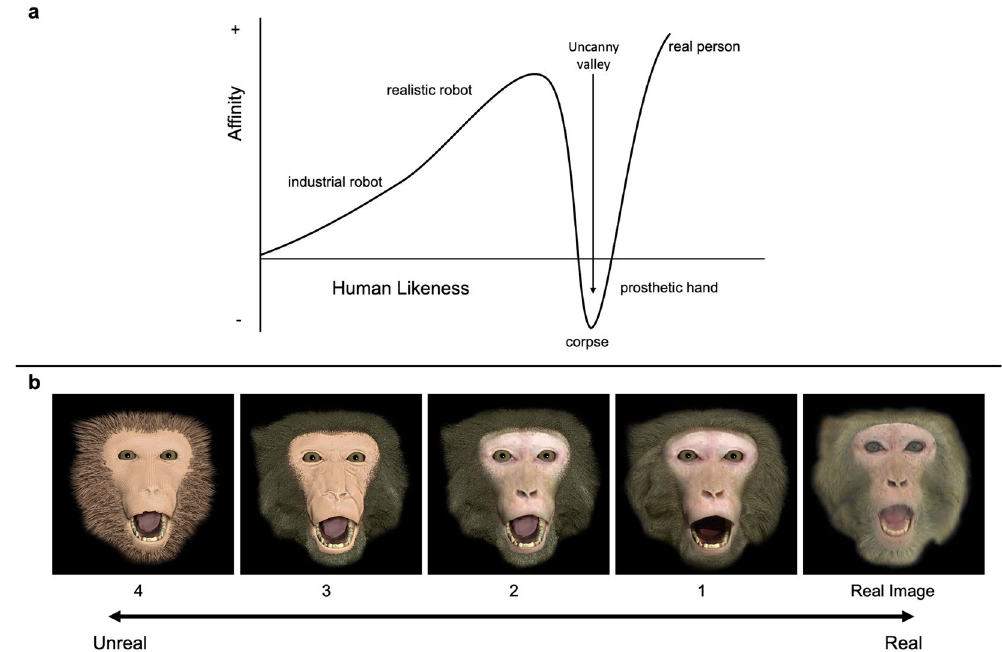
Figure 1. Visual descriptions of the UV hypothesis and stimuli used in the present experiment. ( a ) The UV hypothesis developed by Mori (1970) suggests that as human likeness increases so does affinity, until a certain threshold is reached at which point affinity quickly drops (producing the UV) before spiking up again to its highest level for a real human image. Figure modified from 1,12 . ( b ) Examples of stimulus images we used for a threat face ranging from a Real image of a monkey through increased levels of manipulation (Faces 1 through 4, where Face 4 is the least realistic) to create a realness continuum for each